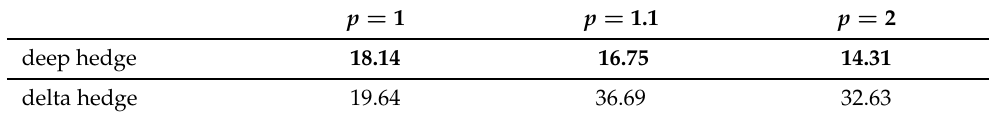
Table 1. Efficient hedging loss for different risk aversion levels without transaction costs.